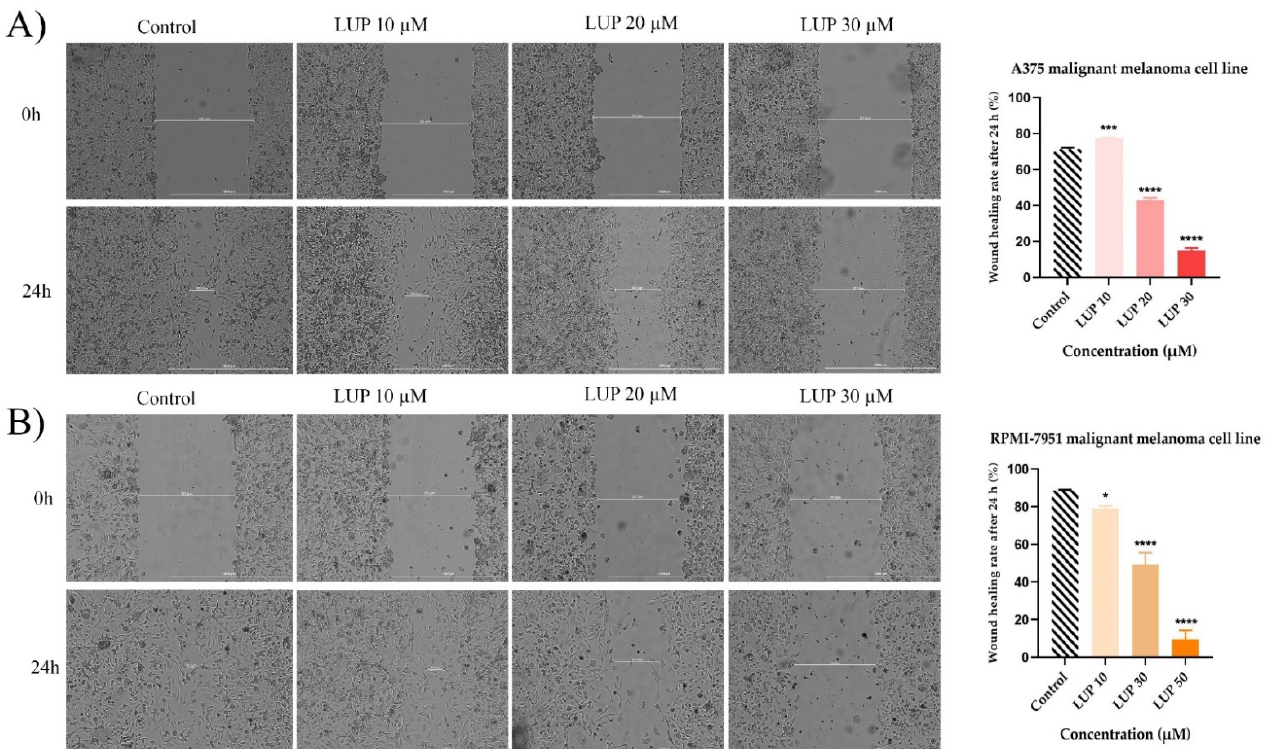
Figure 6. Representative images of the migratory capacity of ( A ) A375 and ( B ) RPMI-7951 MM cells following the treatment with LUP (10, 20, and 30 µ M) for 24 h. The scale bars indicate 1000 µ m. The bar graphs are presented as wound closure percentage after 24 h compared to the initial surface. The data are expressed as mean values ± SD of three independent experiments performed in triplicate. The statistical differences between the control and the LUP-treated group were identified by applying the one-way ANOVA analysis followed by the Dunett’s multiple comparisons post-test (* p < 0.1; *** p < 0.001; **** p < 0.0001).